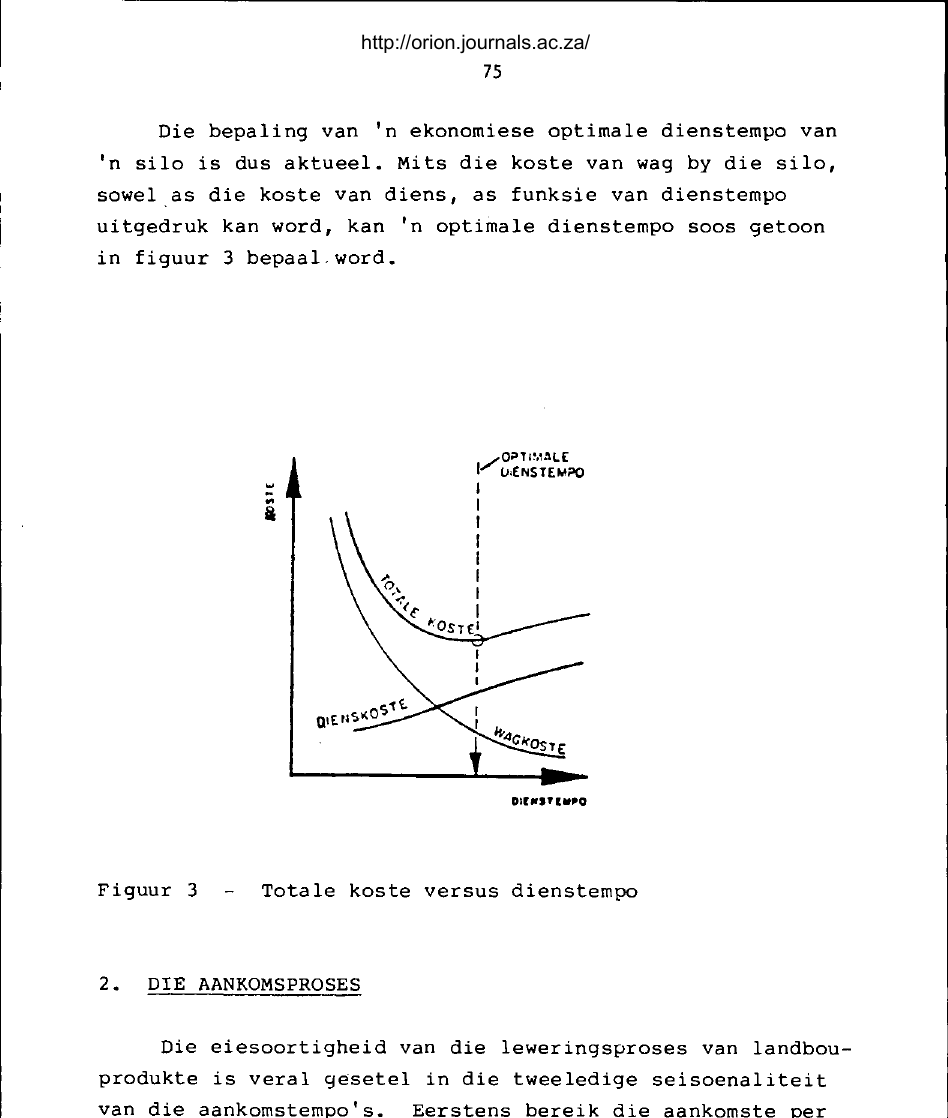
2. DIE AANKOMSPROSES Die eiesoortigheid van die leweringsproses van landbou produkte is veral gesetel in die tweeledige seisoenaliteit van die aankomstempo's. Eerstens bereik die aankomste per dag 'n piek ongeveer in die middel van die oesseisoen. Tweedens het die piekdag ten opsigte van uurlikse aankomste ook een of twee prominente pieke. Die resultate van 'n figure 4 en 5 illustreer beide hierdie verskynsels. Hierdie resultate strook met die van Bouland [2] en Whitney